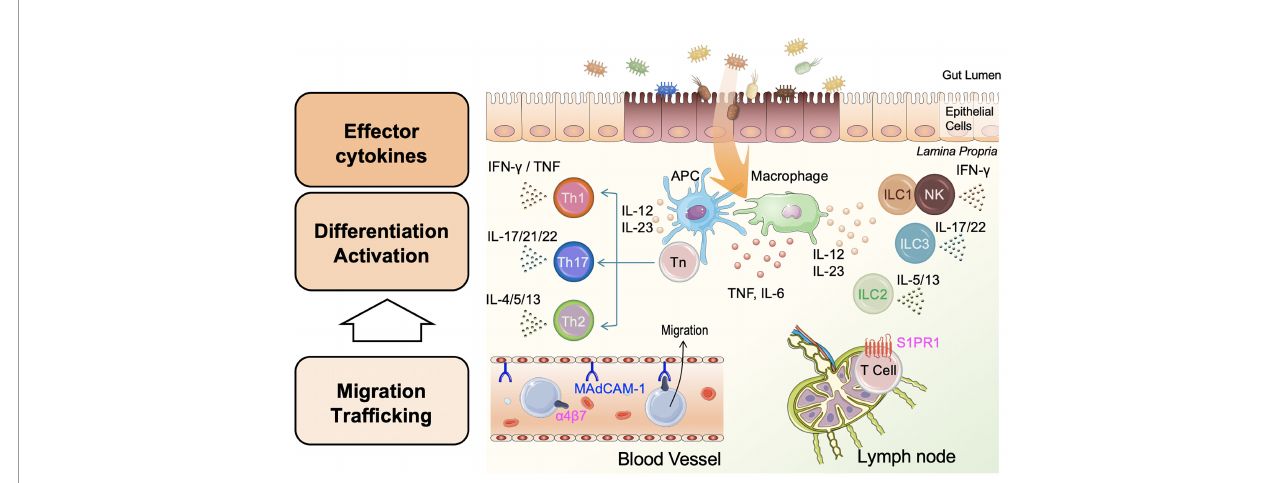
FIGURE 2 | Pathophysiology of in fl ammatory bowel disease (IBD). Damaged epithelial cells enhance antigen presenting cell (APC) and macrophage uptake of antigens such as bacteria in the gut lumen, leading to APC/macrophage activation. APCs and macrophages produce pro-in fl ammatory cytokines, including tumor necrosis factor (TNF), IL-6, IL-12, and IL-23. Activated APCs present processed antigens to naïve helper T-cells (Tn) and promote the differentiation of Tn to effector T-cells, helper T-1 (Th1), Th2, and Th17 cells. Th1 and Th2 release type 1 cytokines (interferon [IFN]- g and TNF), and type 2 cytokines (IL-4, IL-5, and IL-13), respectively. Independent of these, Th17 cells release IL-17, IL-21, and IL-22. Innate lymphoid cells 1 (ILC1s) and natural killer (NK) cells, ILC2s, and ILC3s are activated in a non-antigen-speci fi c manner in tissues and produce cytokines corresponding to adaptive Th cell phenotypes, Th1, Th2, and Th17, respectively. In fl ammation in the lamina propria is involved in the migration and traf fi cking of lymphoid cells from blood vessels and lymph nodes. Circulating lymphoid cells bearing integrin- a 4 b 7 bind to the mucosal vascular epithelium through mucosal addressin-cell adhesion molecule 1 (MAdCAM-1) and migrate to the in fl amed intestine. T-cells expressing shingosine-1-phosphase receptor 1 (S1PR1) in the lymph node are recruited to the site of in fl ammation by stimulation with S1P. Each cytokine or molecule has been targeted for IBD